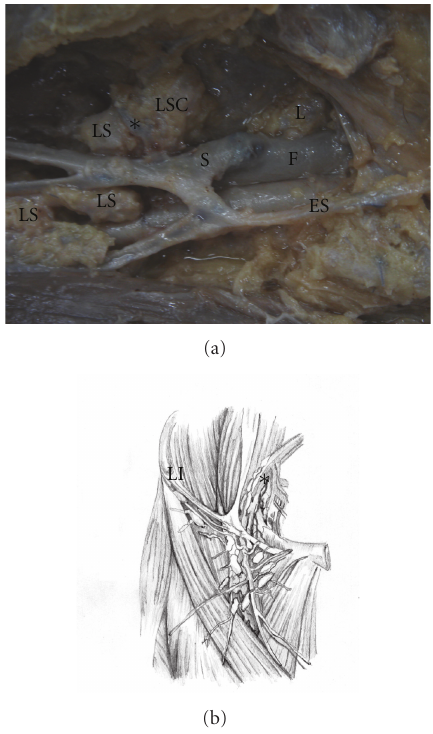
Figure 3: (a) Inguino crural dissection in formalin-preserved cadaver. The superficial nodes (SN) remain in their original posi- tion. In this specimen, just one deep inguinal lymph node is located medially to the femoral vein (F). S: saphena magna vein; SE: superficial epigastric vein; ∗ -external pudendal vein; SSN: superfi- cial sentinel node, as previously described by Cabanas [10, 11]. (b) Schematic draw with superficial and deep nodes of the inguinal region and the iliac nodes.